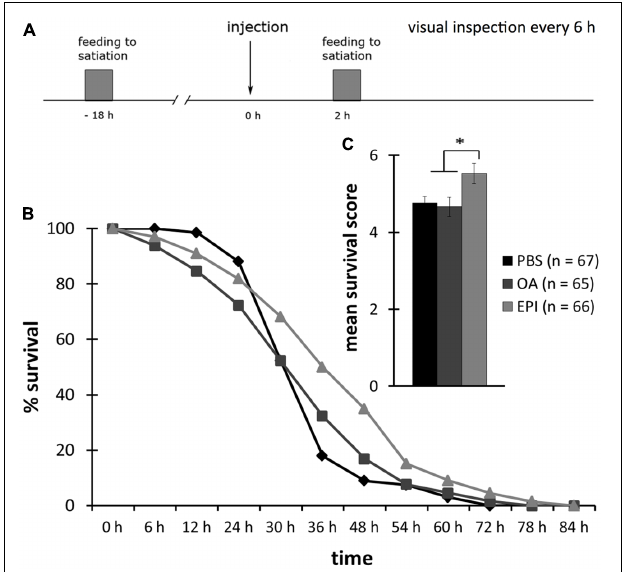
FIGURE 5 | High survival rate of epinastine-treated honeybees that were fed to satiation. (A) Schematic overview of the experiment. Bees were fed to satiation with 30% (w/v) sucrose solution 18 h before injection of octopamine (OA), epinastine (EPI), or PBS. Two hours following drug injection, bees were again fed to satiation with 30% (w/v) sucrose solution (0.88 M). Their survival was observed every 6 h. (B) Survival of bees injected with PBS (rhomb, black), OA (square, dark gray), or EPI (triangle, light gray). (C) No difference in the survival score between bees injected with OA and PBS. EPI-treatment results in a higher survival score than PBS or OA treatment. ∗ p < 0.05. Number of bees appears in brackets.